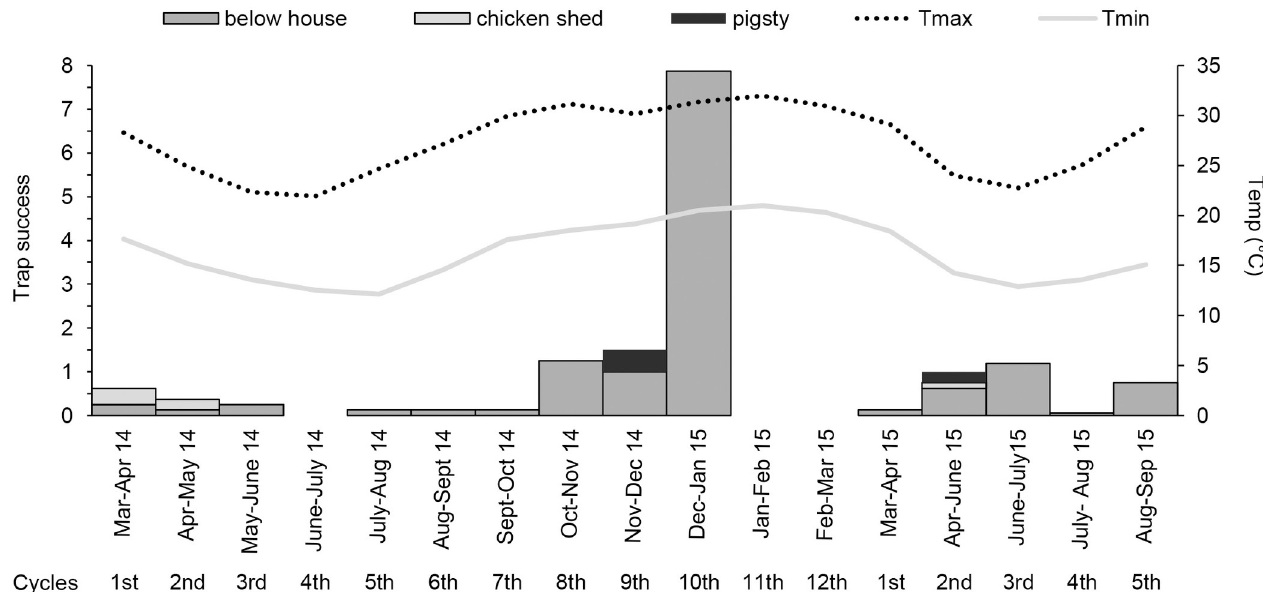
Fig 2. Trap success (number of newly emerged individuals/ number of traps) in each cycle during in the two phases of the first collection period: phase 1 (from March 16 th 2014 to March 26 th 2015–379 nights -12 cycles) and phase 2 (from March 26 th 2015 to October 7 th 2015–195 nights nights—5 cycles), in each environment: below house (dark gray), chicken shed (light gray) and pigsty (black); average maximum temperature (˚C) (dotted line) and minimum temperature (solid line).